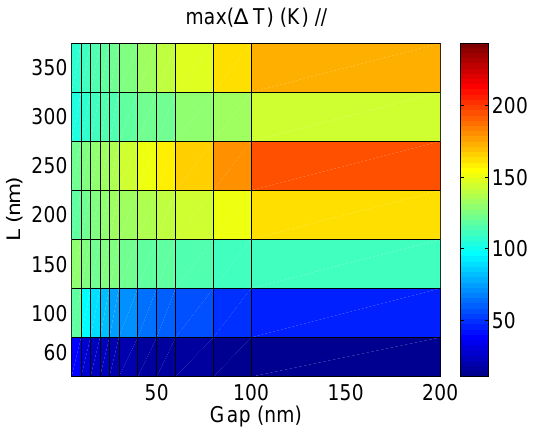
Figure 9: Maximum of intensity | E | 2 , ( V 2 /m 2 ) , as a func- tion of the particle length L and the gap for parallel polar- ization.